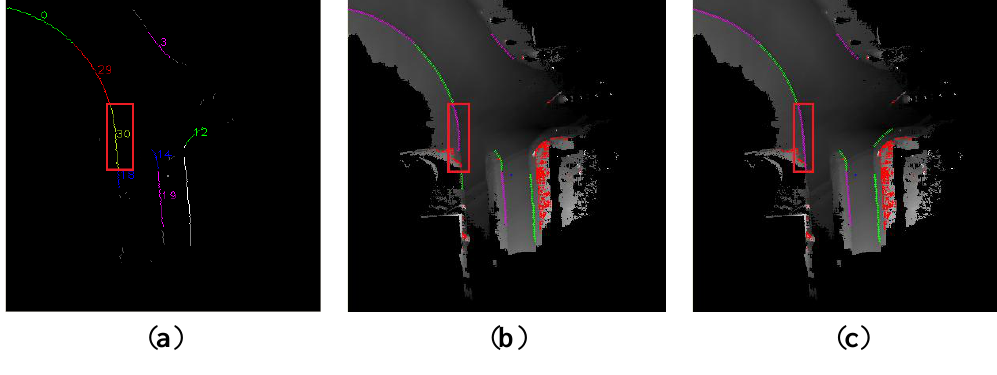
Figure 15. The contrastive result of the curved curb detection. ( a ) Data cluster result in Scene 5. ( b ) The bad curb detection result. ( c ) The result of our method. ( d ) Data cluster result in Scene 6. ( e ) The bad curb detection result. ( f ) The result of our